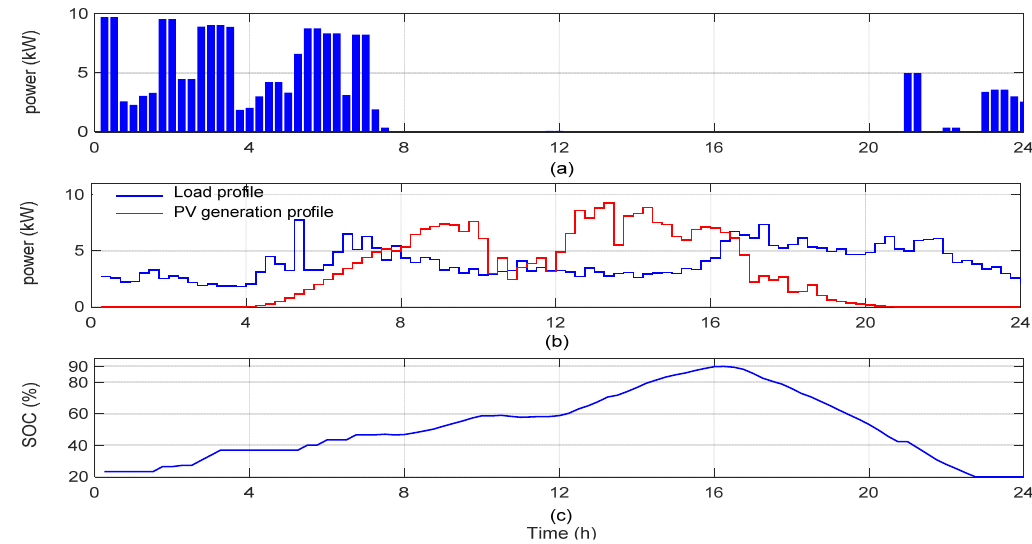
Figure 8. ( a ) Reference values for the power drawn by the MG from the main grid for summer; ( b ) MG’s forecasted load and PV generation profiles; ( c ) Resultant state of charge curve of the BESS.